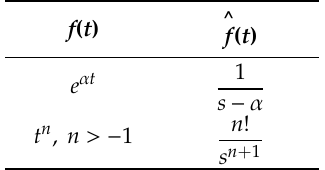
Table 1. Laplace transform